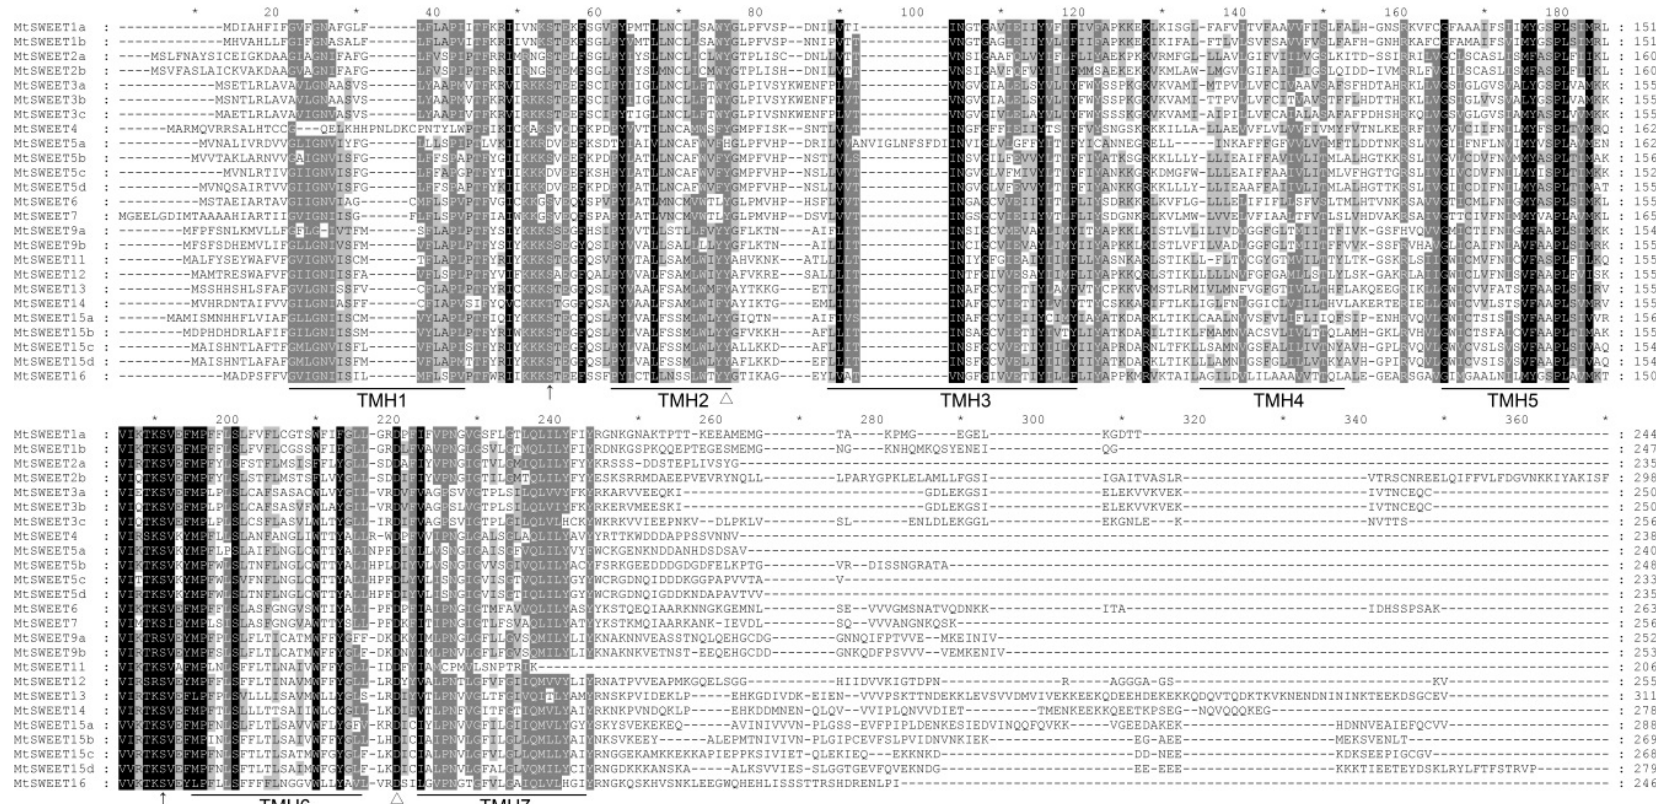
Figure 3. Multiple sequence alignment of MtSWEET proteins. The positions of the TMHs are underlined. The positions of the active sites of tyrosine (Y) and aspartic acid (D) are indicated by triangles. The conserved serine (S) phosphorylation sites are indicated by arrows. The sequence of MtSWEET2b was truncated.